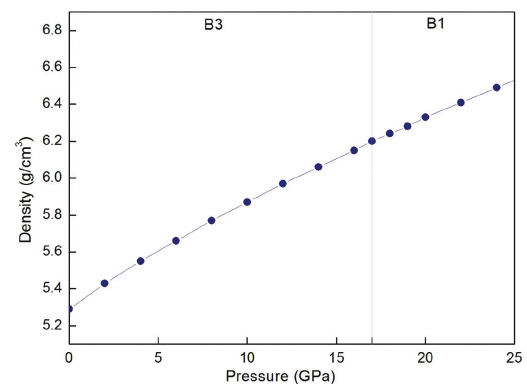
Figure 3. Typical cubic elastic constants C under